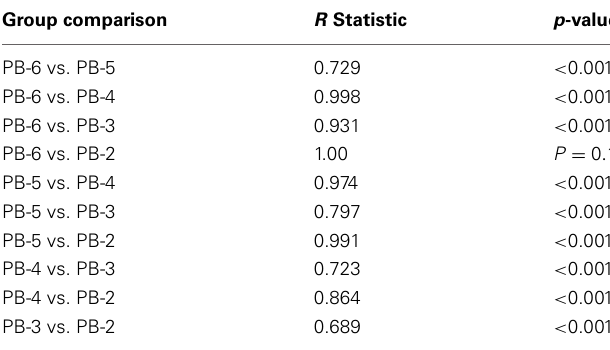
Table 3 | Pair wise post-hoc permutation test (10,000 replications) results for ANOSIM analysis of Holocene local pollen groups described in Table